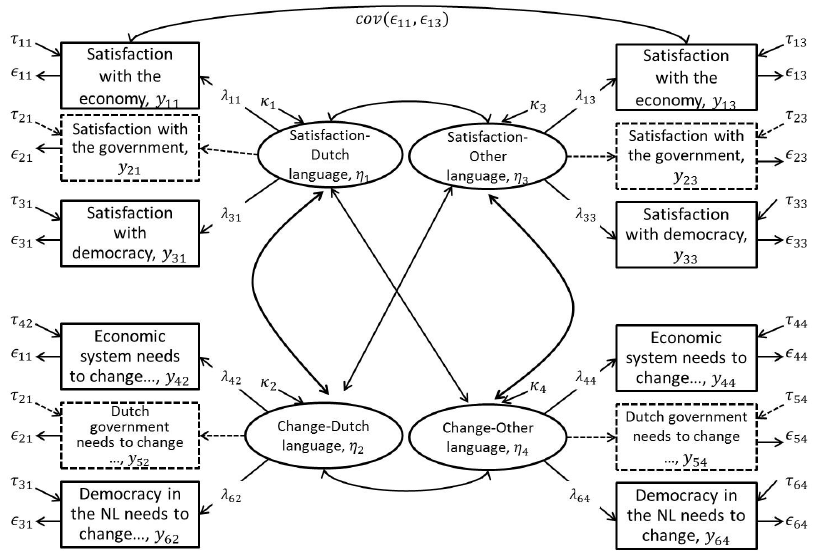
Figure 2 Model 2: ‚Satisfaction and need of change in politics and the